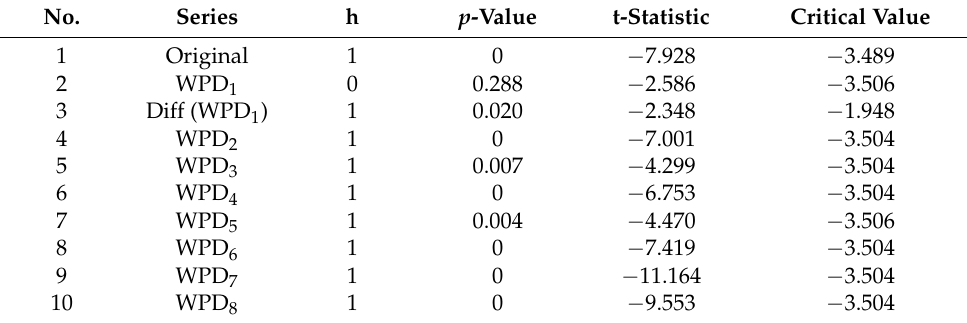
Table 2. Augmented Dickey-Fuller (ADF) test results.